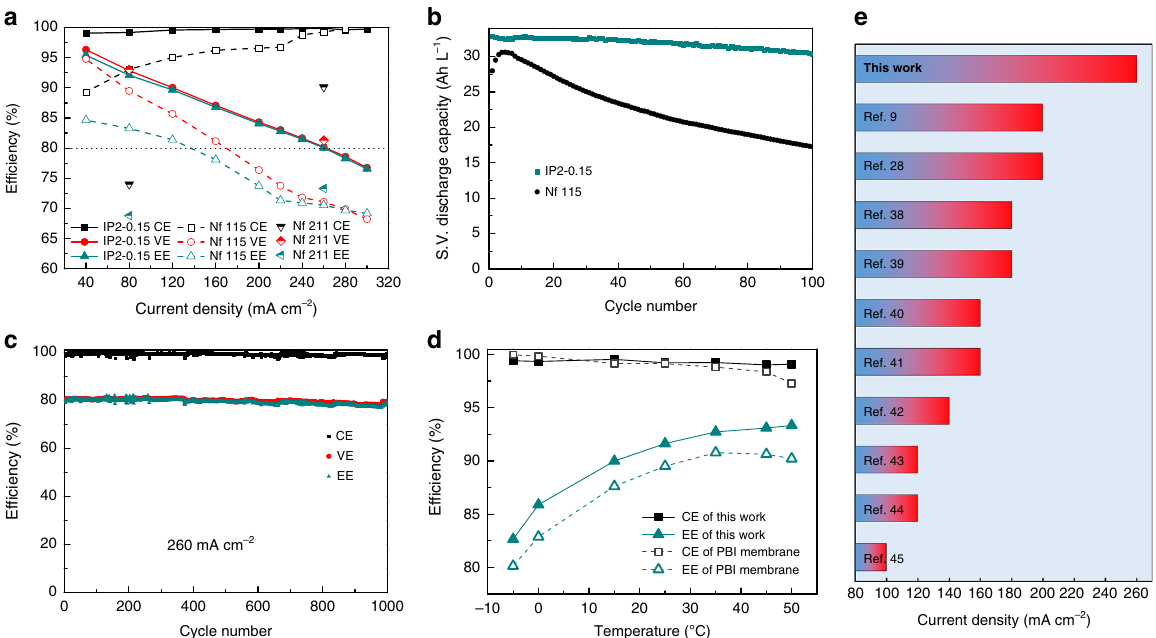
Fig. 5 Battery performance. a Ef fi ciencies of VFBs equipped IP2-0.15 at different current density compared with VFBs equipped with Na fi on 115. b Comparison of speci fi c volume (S.V.) discharge capacity change with the cycle number at a current density of 80 mA cm − 2 . c Cycle performance of VFBs equipped with IP2-0.15 at a current density of 260 mA cm − 2 . d Ef fi ciencies of VFBs equipped with IP2-0.15 and a high-performance porous PBI membrane reported in our previous work 57 . e Comparison of the highest current density with an energy ef fi ciency of about 80% reported in recent fi ve years and our work 58 – 63